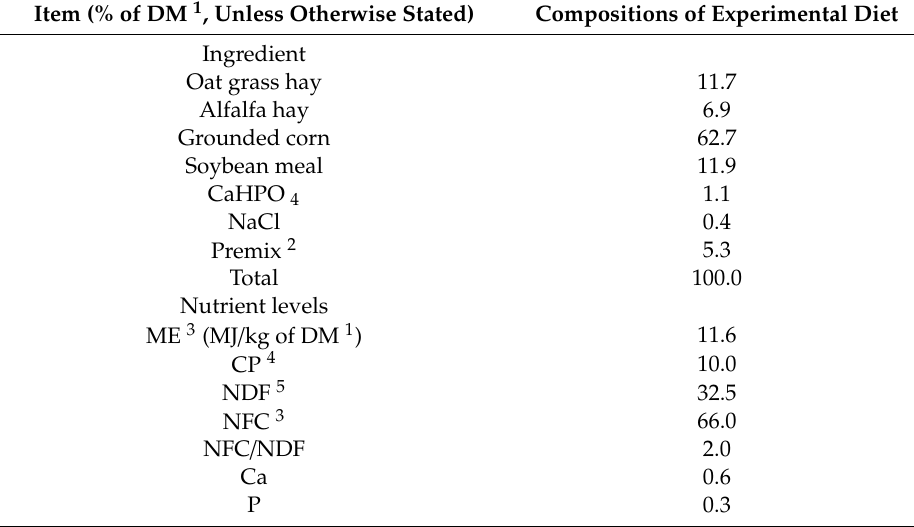
Table 1. Ingredients, composition, and nutrient contents of the experimental diet (DM basis) (%). Item (% of DM 1 , Unless Otherwise